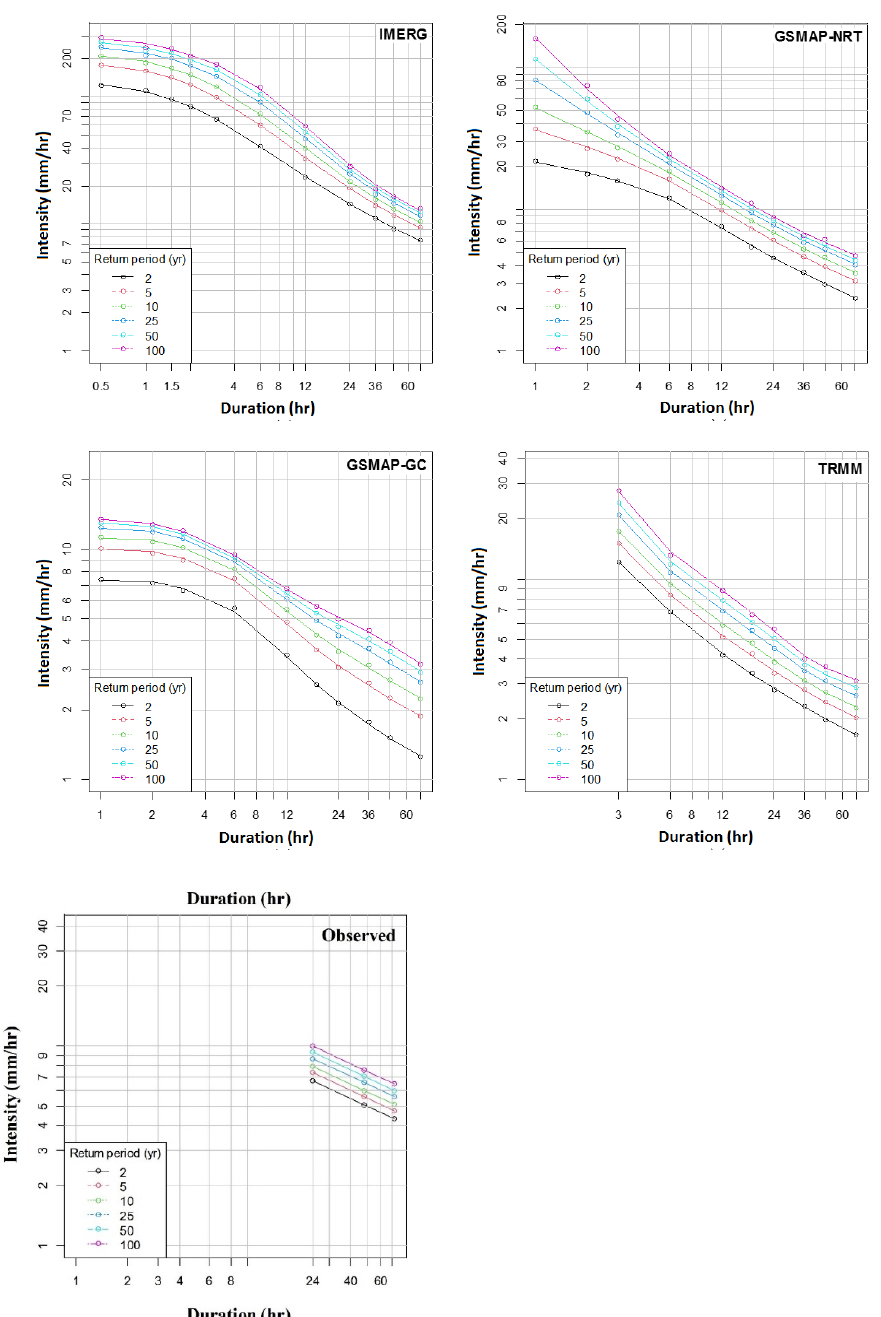
Figure 5. IDF Curves at YIA using satellite and observed precipitation datasets for 2015–2020.